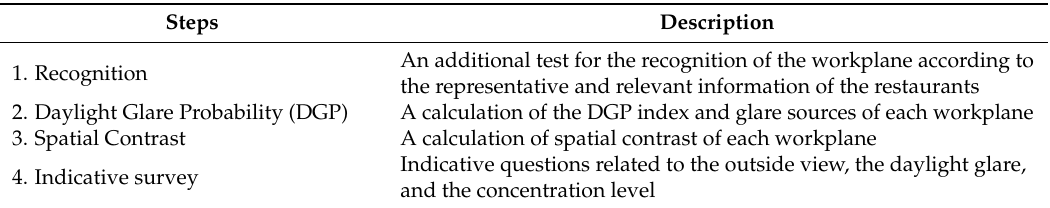
Table 1. Description of the steps of the methodology used.